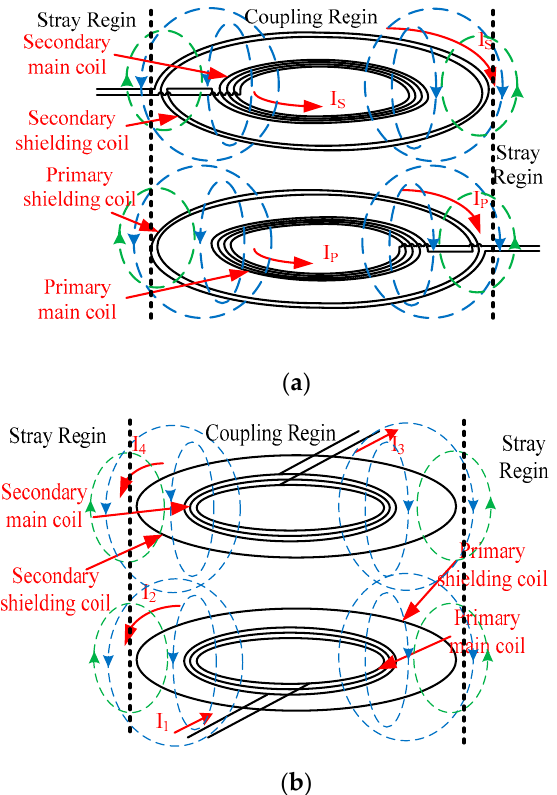
Figure 1. Working schematic diagram of shielding coils where the blue lines mean the EMF excited by power transmission coils and green lines mean the cancel EMF produced by shielding coils: ( a ) the series-opposing structure; ( b ) the inductive structure.